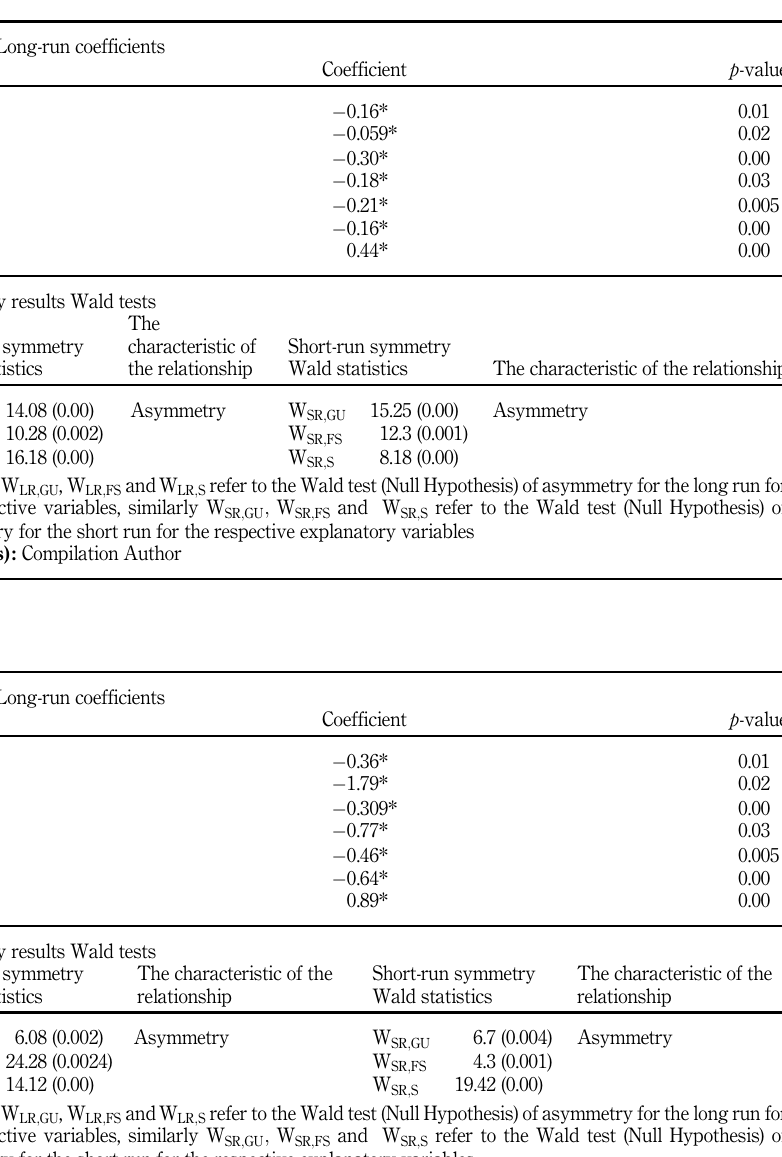
Table A2. Long-run relations and symmetry results. Monthly observations from 2005 to